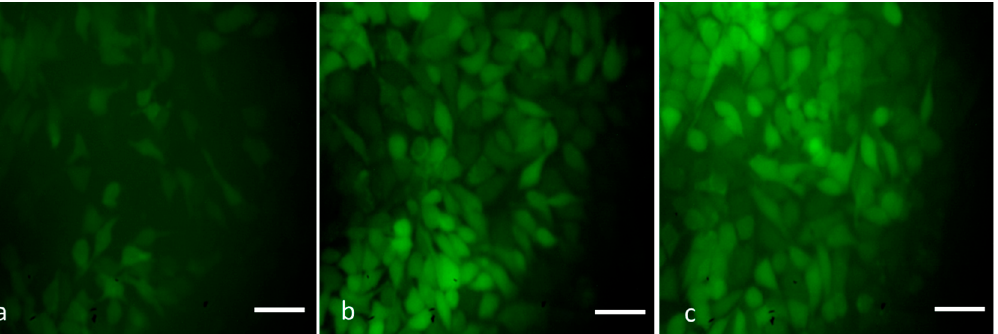
Figure 8. The MDA-MB-231 cell line is subjected to oxidative stress induced by MgO-Chitosan-Pluronic F127-Escin NPs. MgO-Chitosan-Pluronic F127-Escin NPs were used to treat breast cancer MDA-MB-231 cell lines. A representative stained cell for each group was shown against DCFH-DA stained cells. Control ( a ), 10 µg/mL of MgO-Chitosan-Pluronic F127-Escin NPs-treated cells ( b ), and 20 µg/mL of MgO-Chitosan-Pluronic F127-Escin NPs-treated cells ( c ). 20X magnification was used to capture the images (scale bar 50 µm).